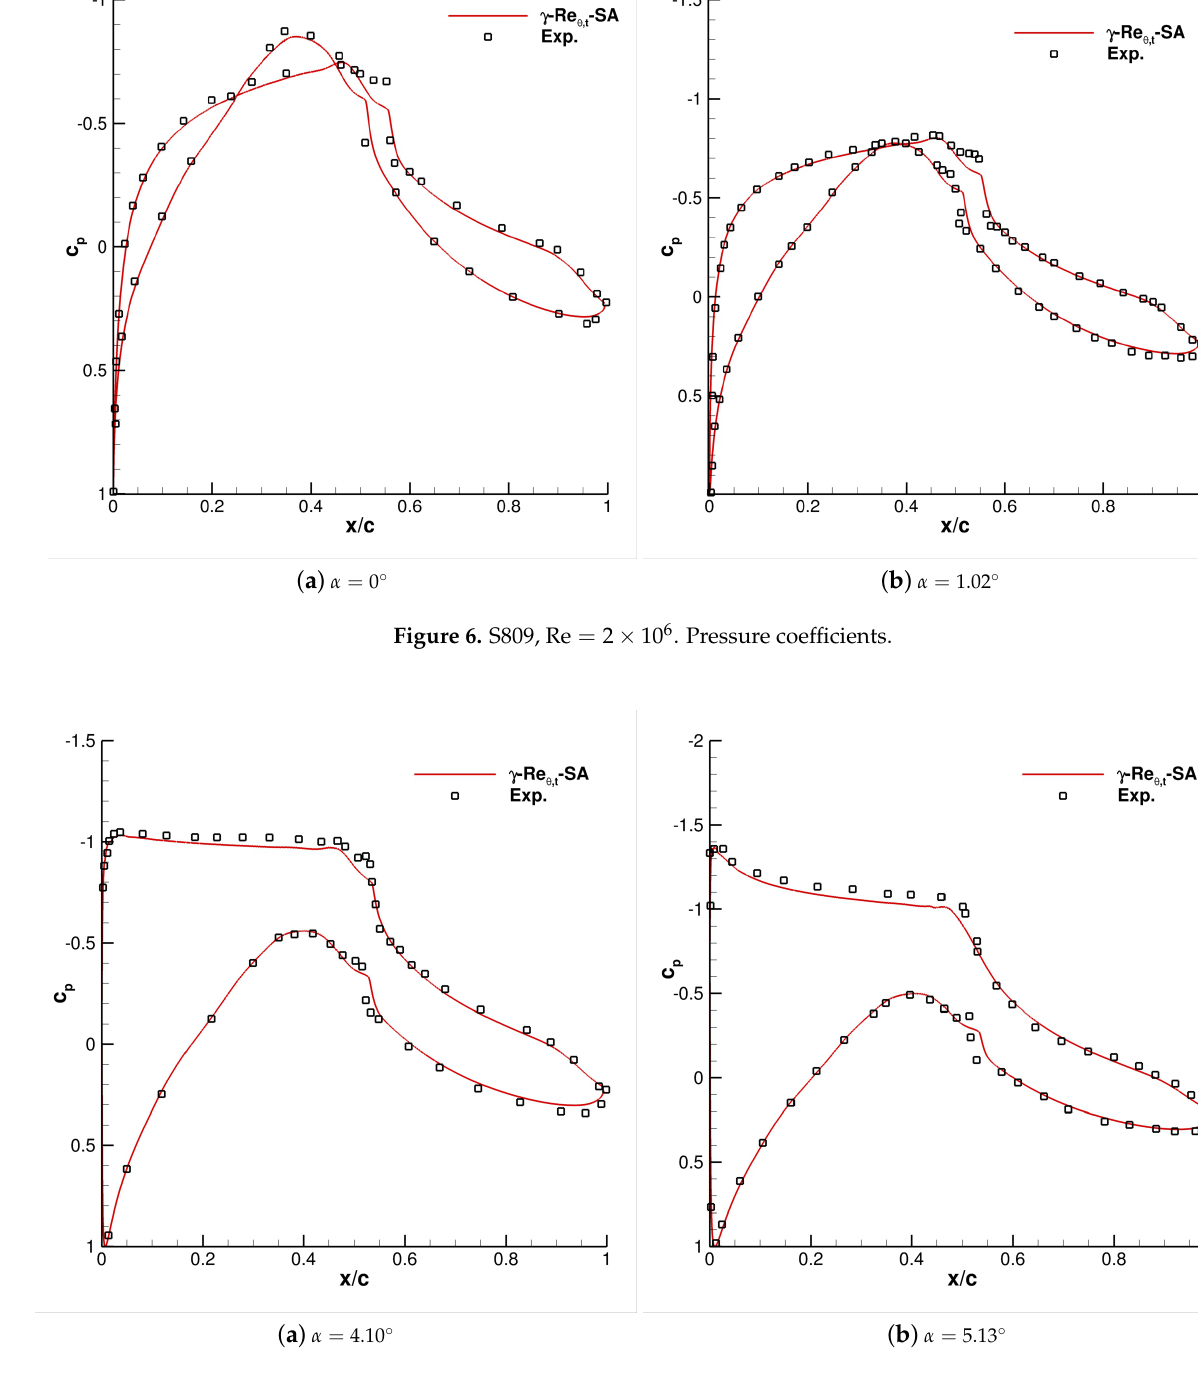
Figure 7. S809, Re = 2 × 10 6 . Pressure